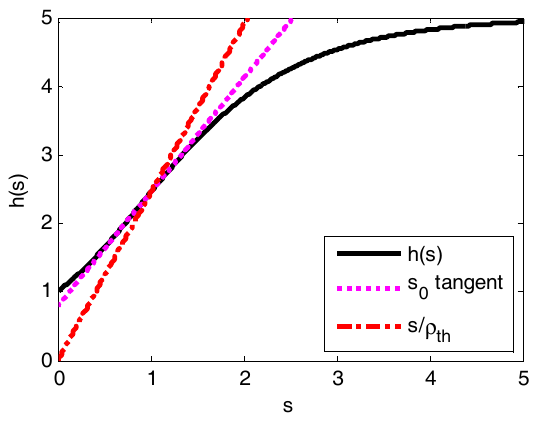
Figure 3. Function h ( s ) for Q = 5, s 0 is the inflexion point of h ( s ).